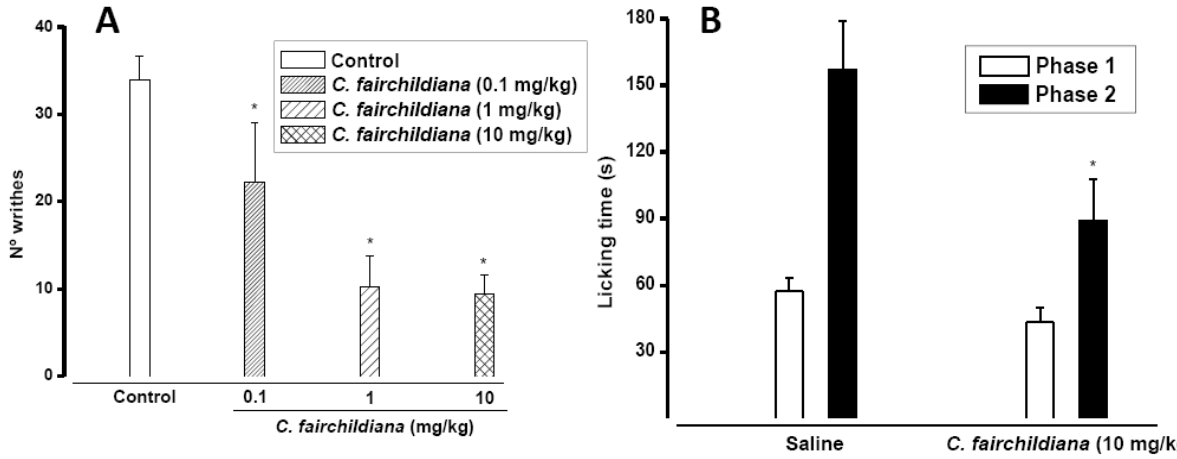
Figure 2. Antinociceptive effect of C. fairchildiana lectin. ( A ) C. fairchildiana lectin (0.1, 1, 10 mg/kg; i.v.) was injected in mice 30 min before 0.8% acetic acid (v/v; i.p.). Control group received acetic acid only; ( B ) C. fairchildiana lectin (10 mg/kg)